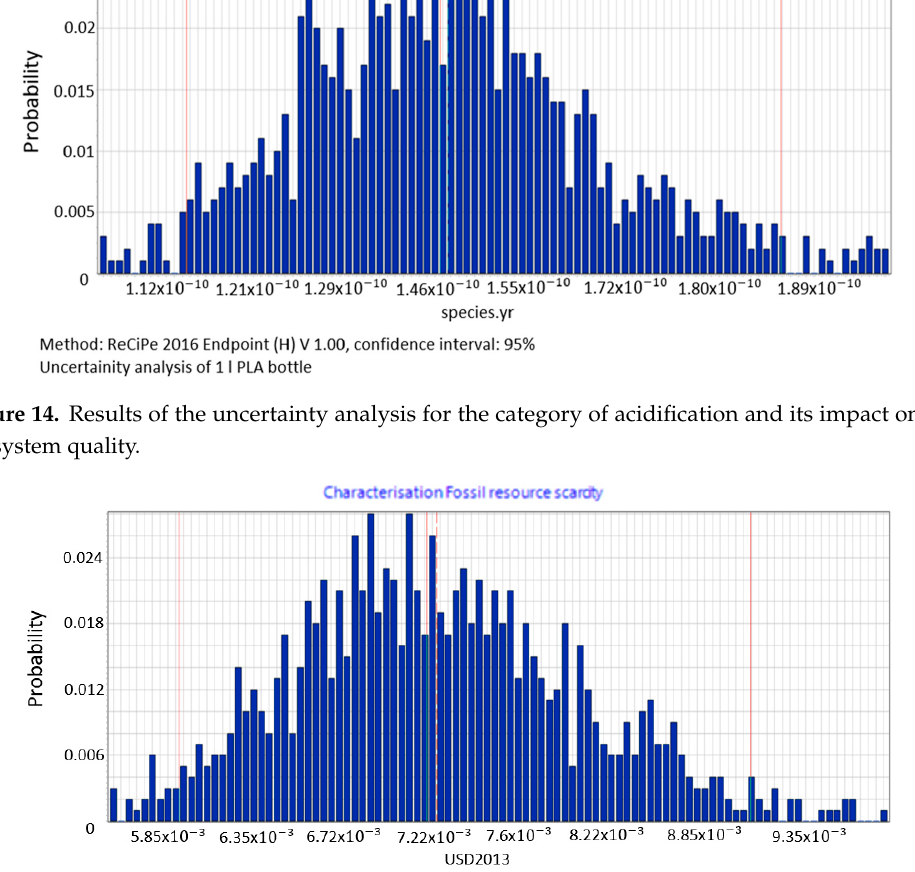
Figure 15. Results of the uncertainty analysis for the category of fossil resources scarcity and its impact on the resources availability.